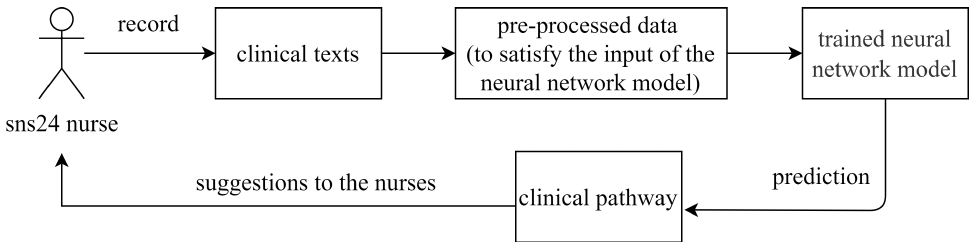
Figure 1. Applying deep learning approaches on SNS24 clinical trial classification. The clinical texts which are recorded by SNS24 nurses are pre-processed and as the input of the neural network models. Using the designed deep learning architectures, neural network models are trained to predict clinical pathways and provide suggestions to the